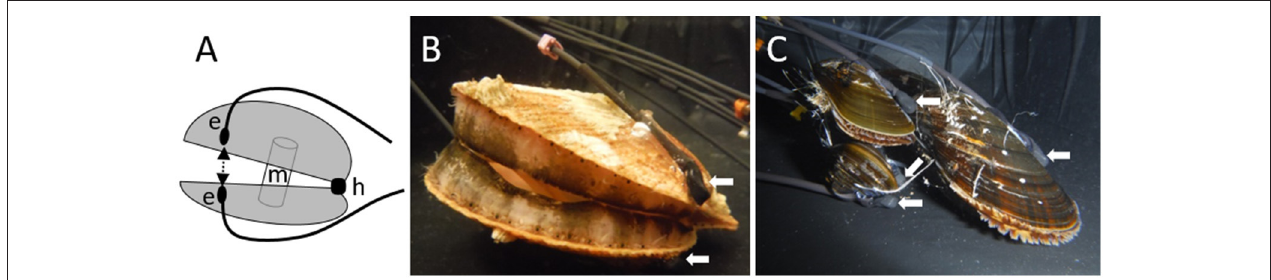
FIGURE 1 | Schematic representation of the High frequency non-invasive electrodes glued to a bivalve (A) showing the position of the electrodes (e), the muscle (m) and the hinge (h). The Icelandic scallop Chlamys islandica (B) and blue mussels Mytilus edulis (C) are some of the latest species where the HFNI valvomenter is employed. The white arrows indicate the position of the electrodes. Photo credit: J-C Massabuau.